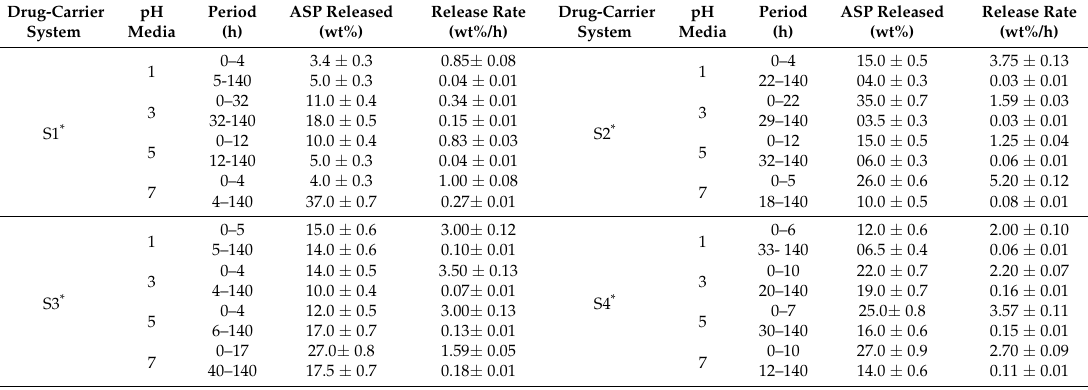
Table 6. The results obtained from the main pseudo-stable zones of the dynamic release of ASP from the ASP/PE- co -VAL/P δ -VL50 drug-carrier